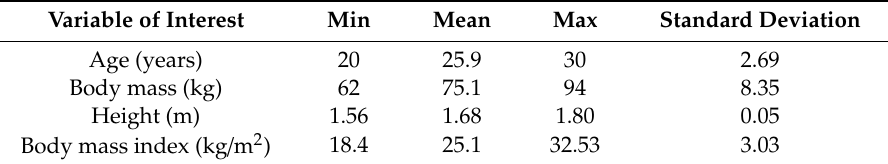
Table 1. Characteristics of the participants (N = 31 males).